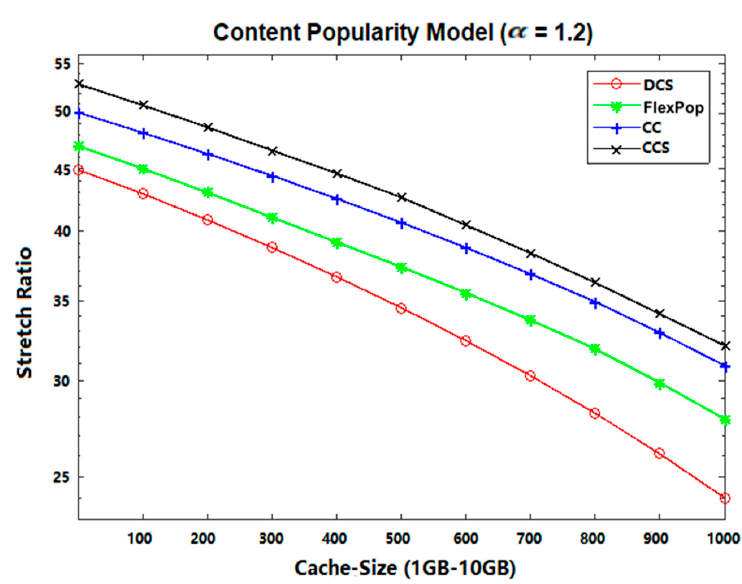
Figure 10. Stretch Ratio on GEANT Topology with VoD.